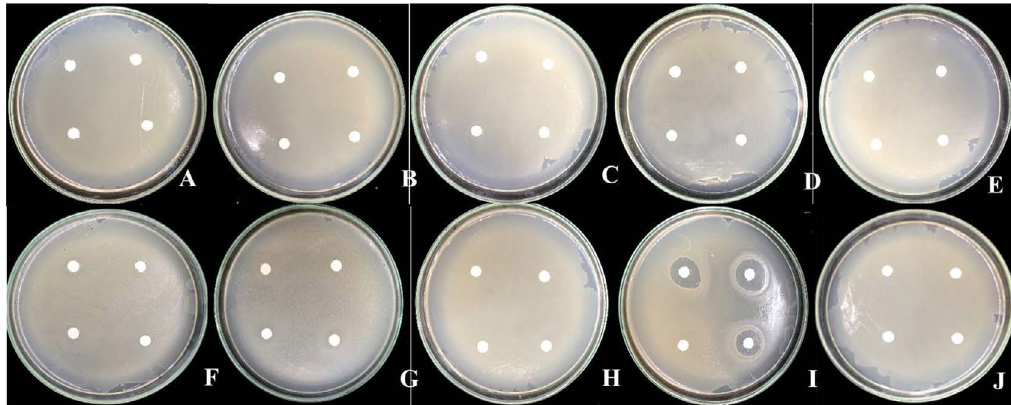
Fig. 1. Compatibility test of antagonistic bacteria Bacillus pumilus FDKF5 and pesticides A: pyridaben 20% WP, B: imidachloprid 70% WG, C: carbosulfan 20% W/V EC, D: sulfur 80% WG, E: abamectin 1.8% W/V EC, F: etridiazole 6% + quintozene 4% W/V EC, G: benomyl 50% WP, H: prochloraz 50% WP, I: streptomycin, J: dH 2